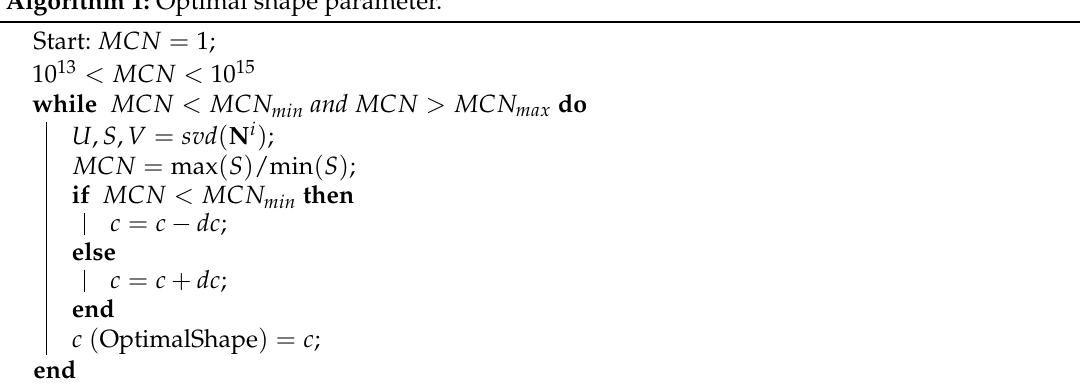
Algorithm 1: Optimal shape